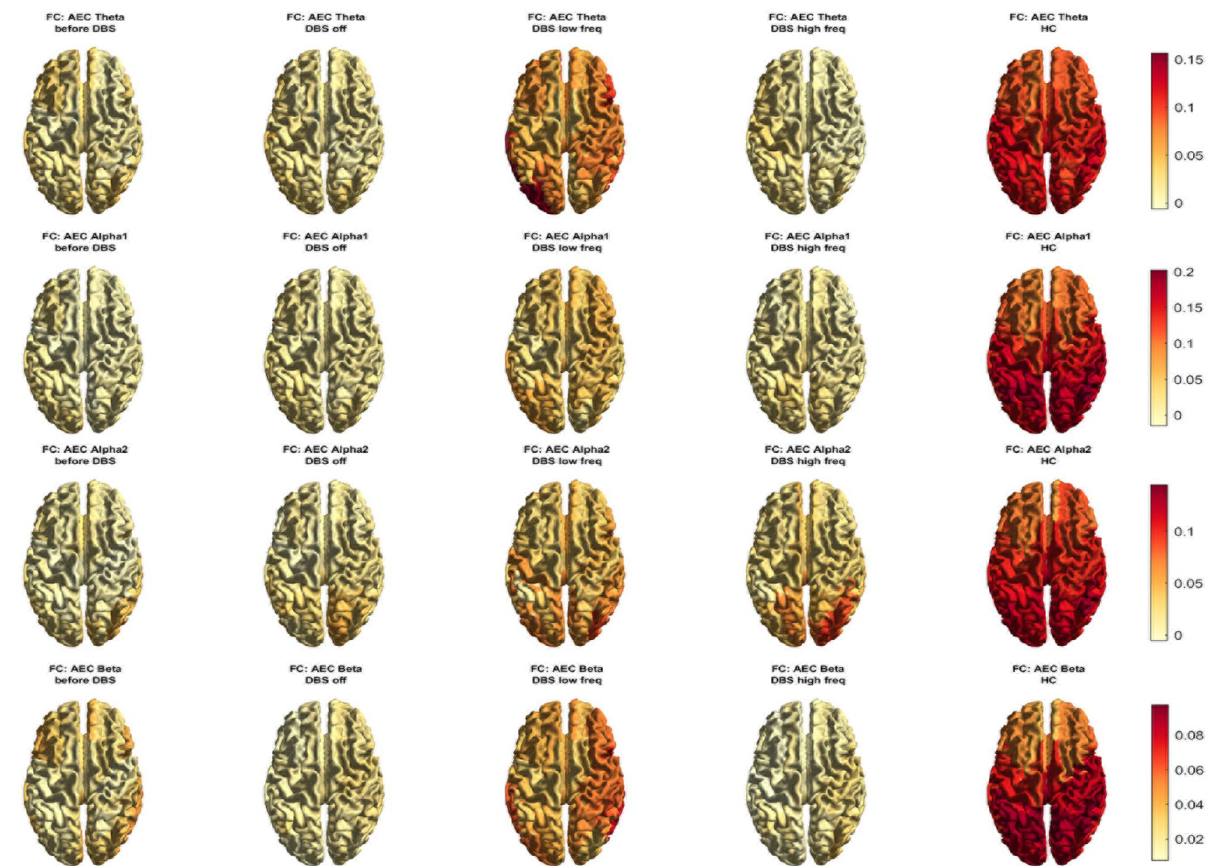
Figure 2. MEG functional connectivity (AECc) for the four different conditions in the patient, and for healthy controls (HC) displayed as a color-coded map on a parcellated template brain, viewed from above. For visualization purposes, only cortical brain regions are displayed. From top to bottom: theta, alpha1, alpha2, and beta-band functional connectivity. Note that different colorbars were used for the different frequency bands. Before DBS = before implantation DBS, DBS low freq = deep brain stimulation at 50 Hz/450 μsec, DBS high freq = deep brain stimulation at 130 Hz/60 μsec, DBS off = resting-state before